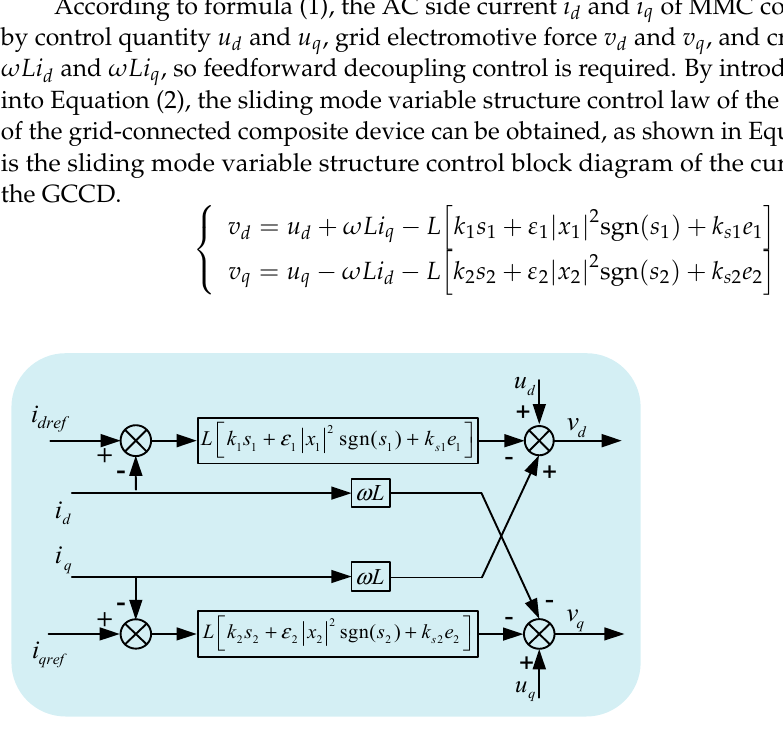
Figure 3. Structural block diagram of current inner loop sliding mode variable control strategy.